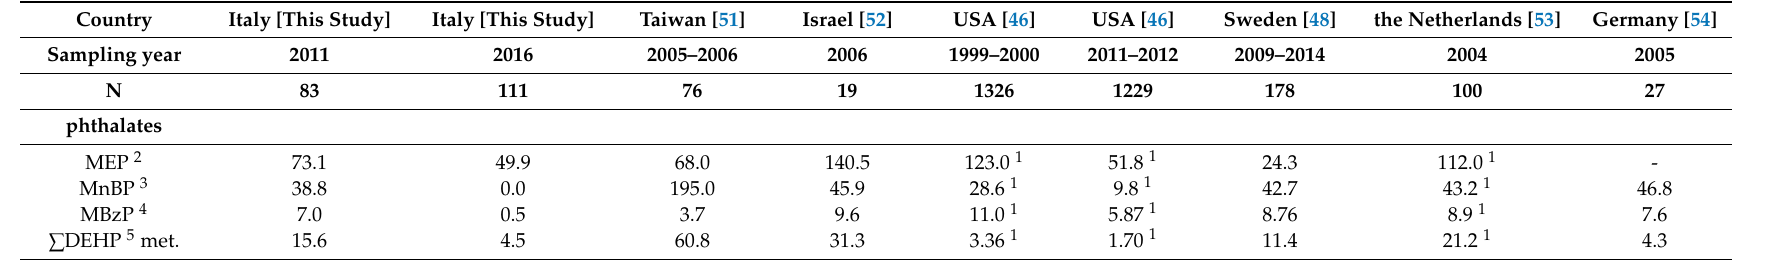
Table 7. Comparison among biomonitoring median data in different geographical areas—women ( µ g/g creatinine). Country Italy [This Study] Italy [This Study]